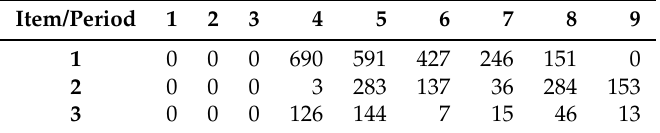
Table 4. Periodical inventory held in units per item during the shifted planning horizon. Item/Period